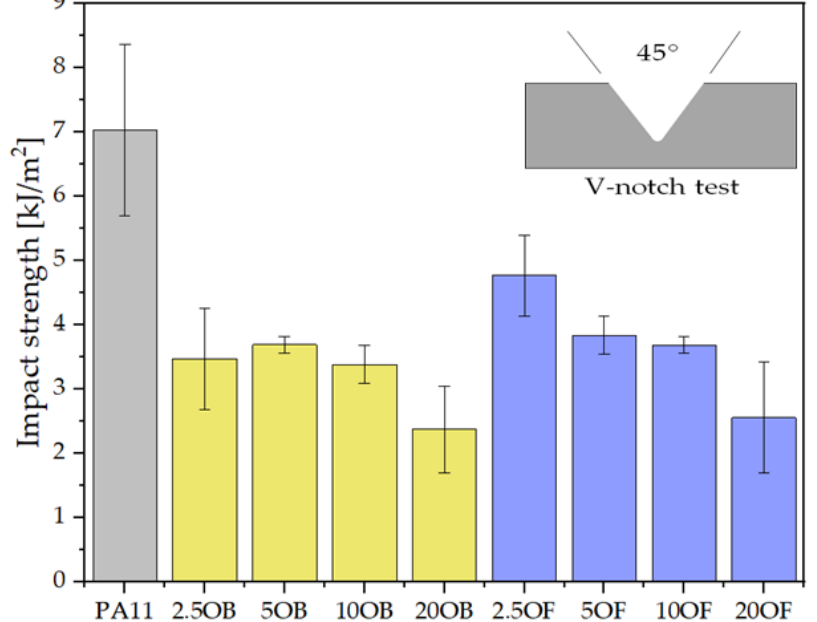
Figure 10. The results of static flexural strength test: maximum bending stress and modulus of elasticity.